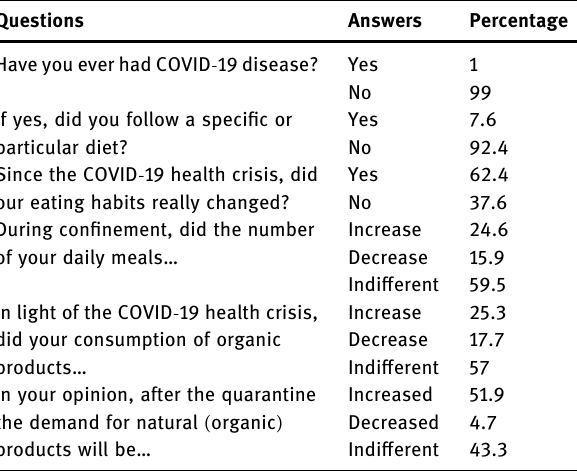
Table 4: Eating behavior during the COVID - 19 health